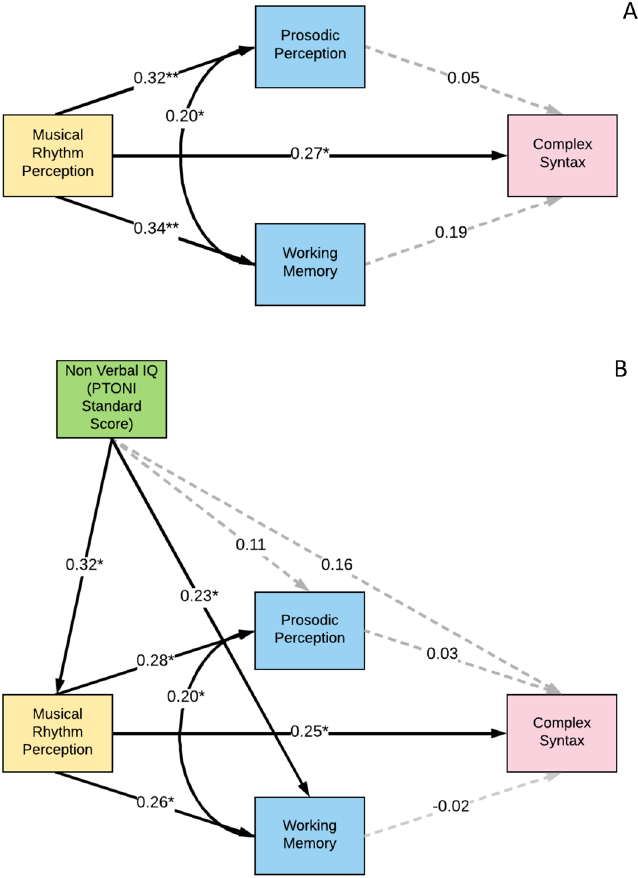
Figure 5. Path analysis model for musical rhythm perception and complex syntax, with and without nonverbal IQ as a covariate. ( A ) Panel A ( n = 109) depicts the path model for musical rhythm perception and complex syntax, with prosodic perception and working memory as mediators. Residualised scores were created by partialling age from z-scored raw scores of all variables. The age-residualised scores were then z-scored and used in the path model. We find that the relationship between musical rhythm perception and complex syntax task performance is non-significant. Solid lines indicate a significant relationship. *signifies p < 0.05, while **signifies p < 0.001. ( B ). Panel B shows the path analysis model for musical rhythm perception and complex syntax, controlling for IQ ( n = 103). Residualised scores were created by partialling age from the z-scores of all variables, except for IQ. For IQ we used z-scored standard PTONI scores. The z-scored, age-regressed residual scores, and z-scored PTONI standard scores were used in the path model. The β for each pair of variables is indicated on the path. Even by controlling for IQ, the relationship between musical rhythm perception and complex syntax remains non-significant. Solid lines indicate a significant relationship. *signifies p < 0.05, while **signifies p <